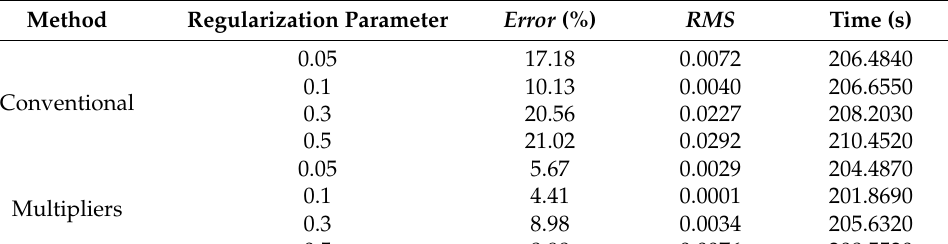
Table 2. Model errors, RMS data fitting error, and inversion times for different regularization factors of the wedge model.